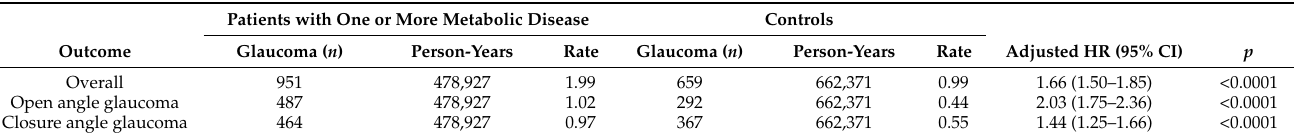
Table 4. Incidence rates of open angle glaucoma and Closure angle glaucoma and metabolism disease cohort to control cohort adjusted hazard